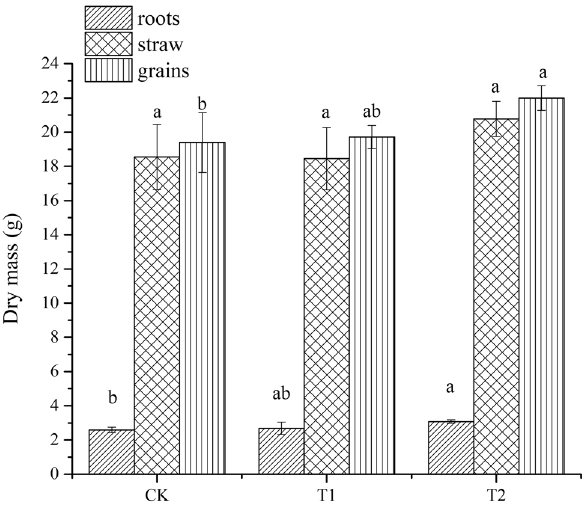
Figure 6. Roots, straw, and grains dry masses of rice. Different letters represented significant difference at P <